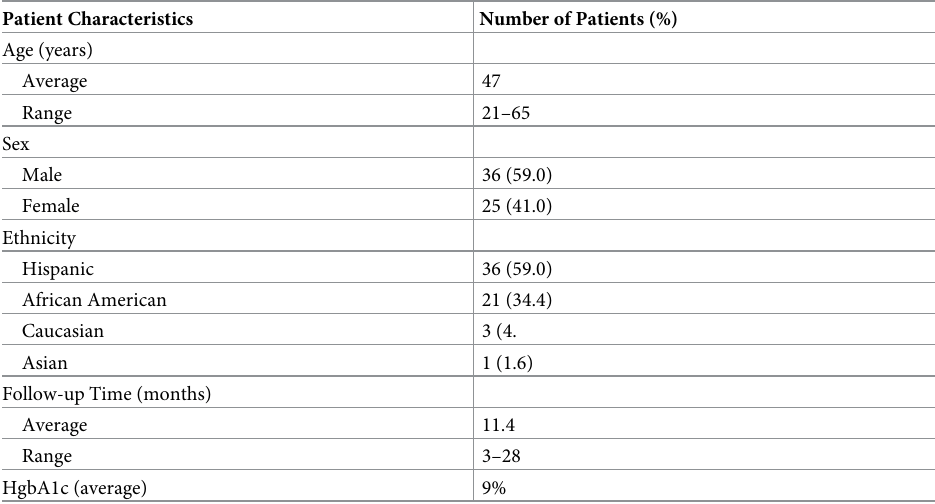
Table 1. Patient characteristics (n =